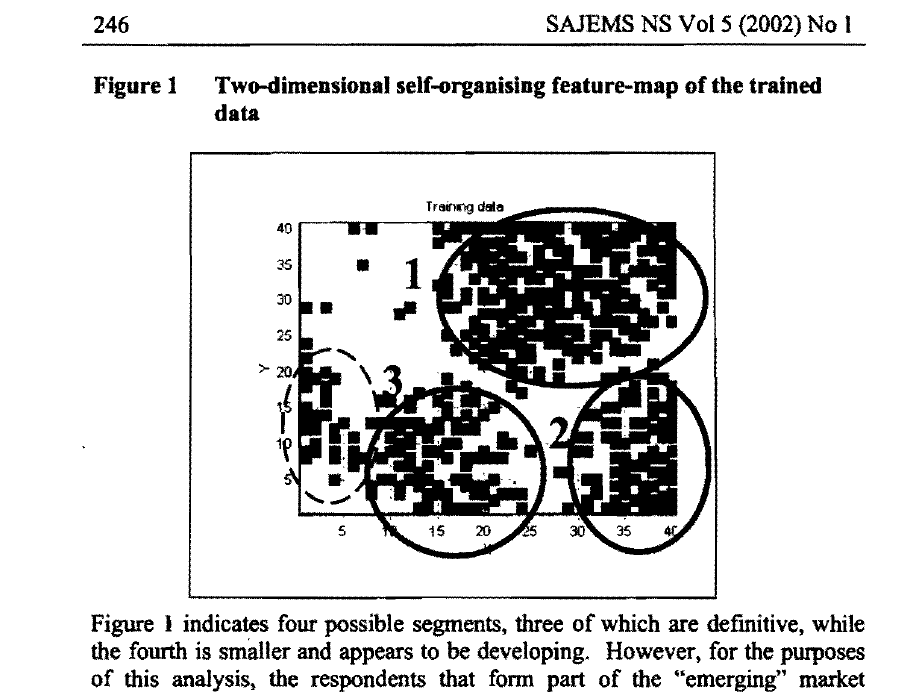
Two-dimensional self-organising feature-map of the trained data